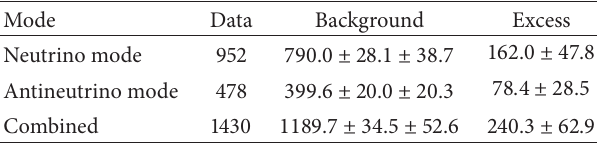
Table 4: The number of data, fitted (constrained) backgrounds, and excess events in the ] 𝑒 and ] 𝑒 analyses for neutrino mode, antineutrino mode, and combined in the neutrino oscillation energy range from 200 to 1250 MeV. The uncertainties include both statistical and constrained systematic errors. All known systematic errors are included in the systematic error